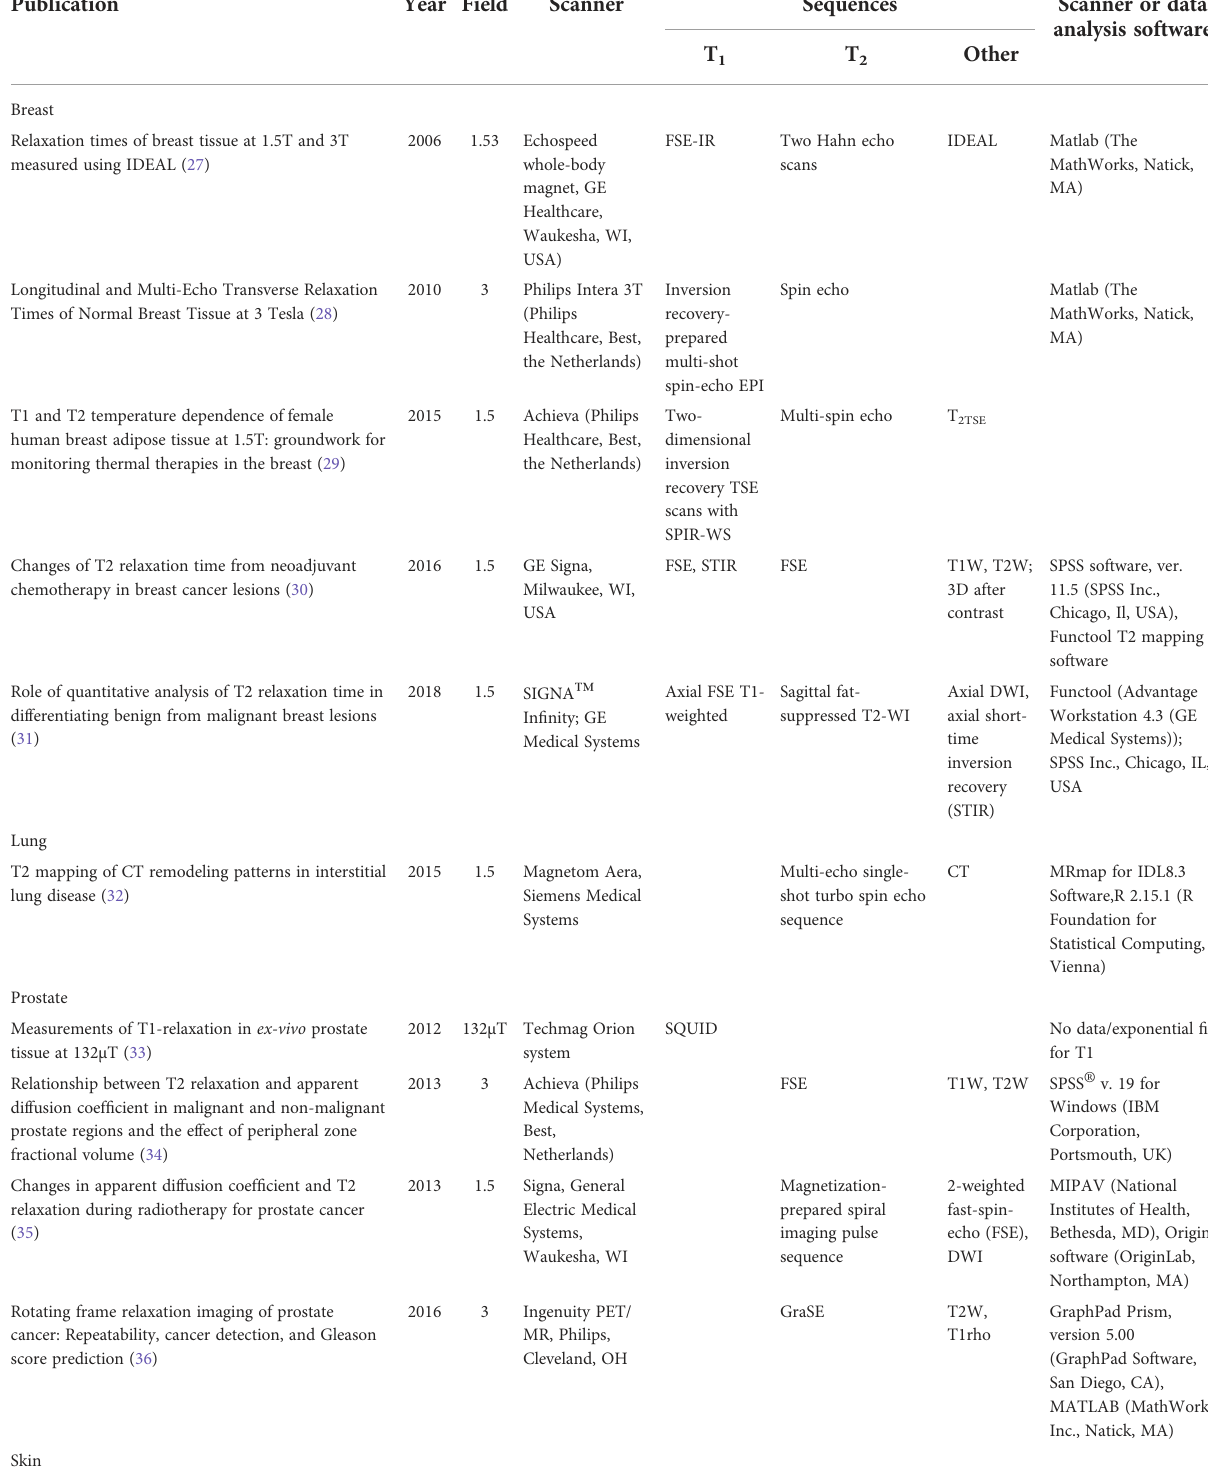
TABLE 3 Technical aspects of publications chosen for the detailed